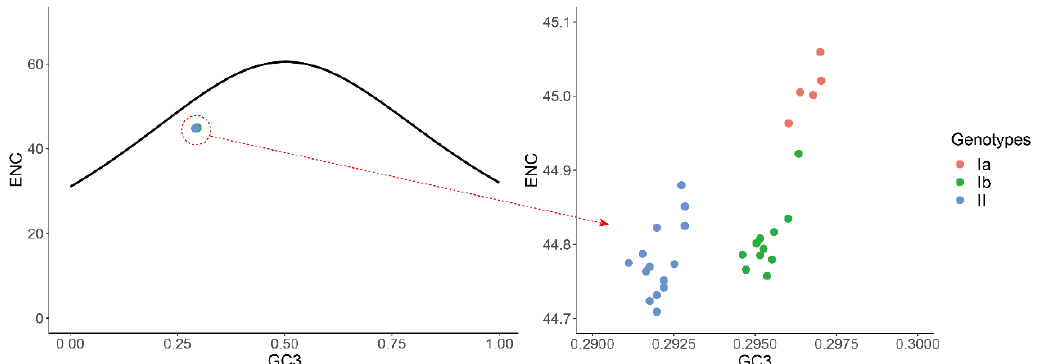
Figure 5. ENC plot analysis of the TGEV complete CDS. The relationships between ENC values and GC contents at the third codon position (GC3s) of synonymous codons are represent. The expected curve represents the expected ENC values toward all GC3 compositions. Genotypes Ia, Ib, and II are represented in orange, green, and blue, respectively.